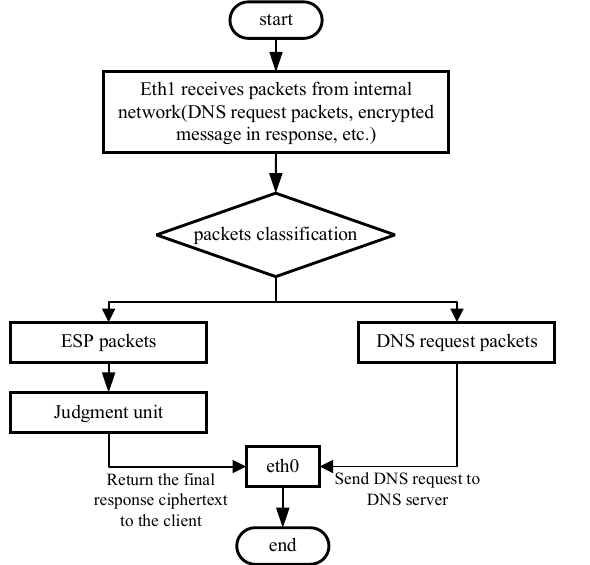
Figure 4. Workflow of